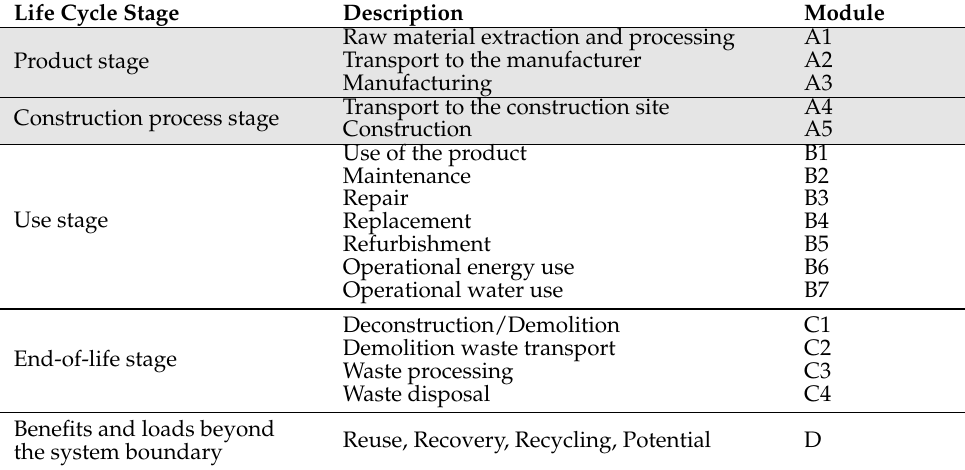
Table 4. System boundaries according to EN 15804 and EN